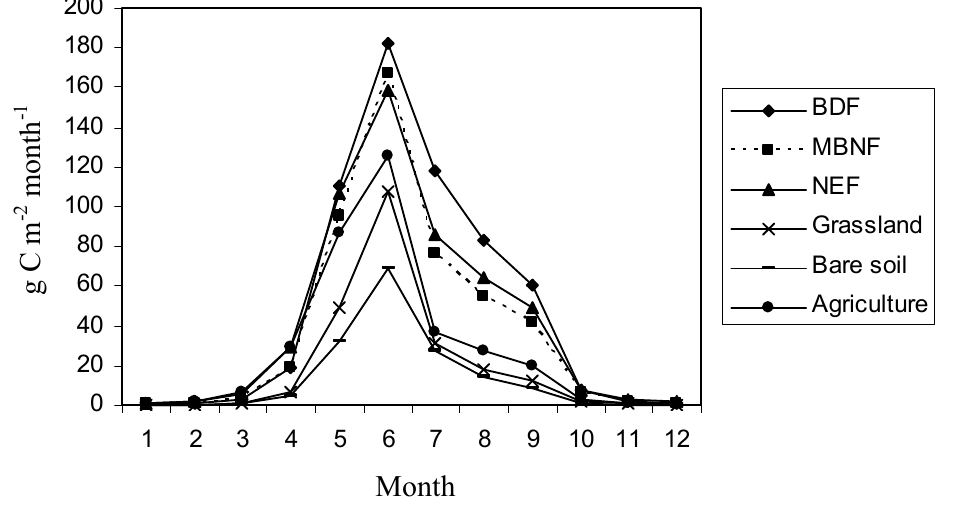
Figure 9. Monthly NPP estimates of major land covers and land uses of Seyhan watershed according to the CASA algorithm: BDF: Broadleaf deciduous forest; NEF: Needleleaf evergreen forest; MBNF: Mixed broadleaf and needleleaf